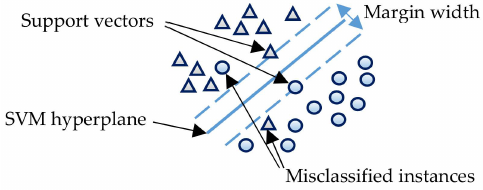
Figure 1. The SVM classification with a